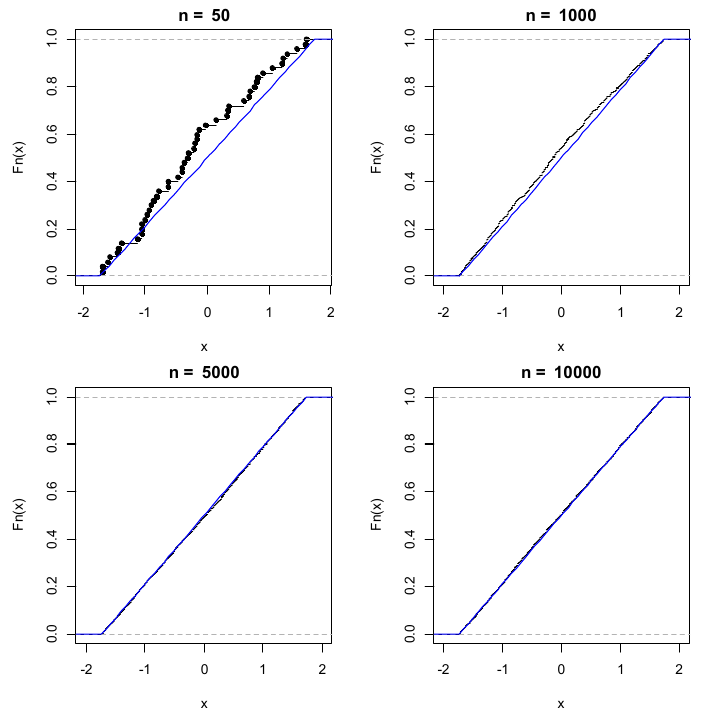
Figure 3. The effect of different bootstrap sampling sizes n = 50, n = 100, n = 5000 and n = 10,000 on the sampling distribution of H. armigera first flight.